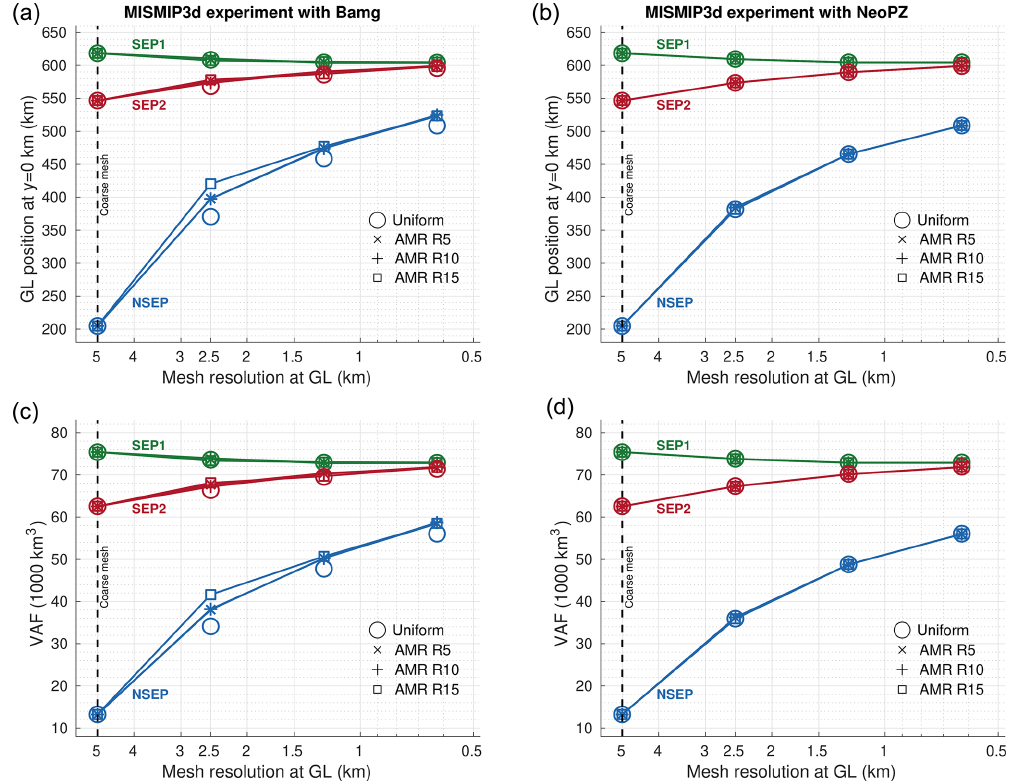
Figure 5. GL positions (a, b) and VAF (c, d) at steady state obtained from the coarse mesh and from AMR using the refinement criterion based on the element distance to the GL, R gl . Three element distances are used and compared: R gl of 5, 10 and 15km. The meshes generated with these distances are labeled as AMR R5, AMR R10 and AMR R15, respectively (see Tables 1 and 2). Results from uniformly refined meshes (labeled as uniform) are also shown. The simulations are carried out through the mesh generators Bamg (a, c) and NeoPZ (b, d) using three sub-element parameterizations: NSEP, SEP1 and